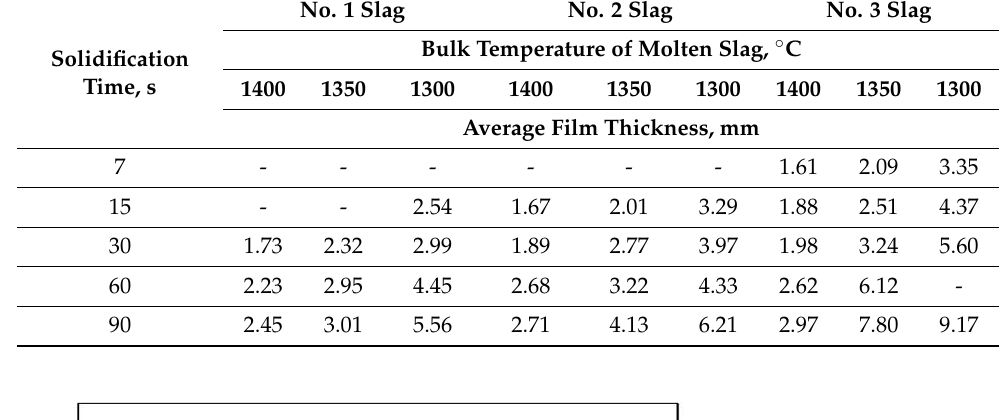
Table 2. Average thickness of slag films with different solidification times and slag bulk temperatures.